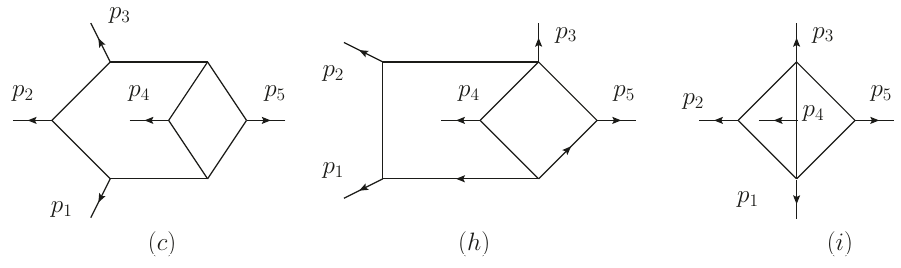
Figure 2 . Non-planar integral sectors with genuine five-particle kinematics. The labelling follows that of